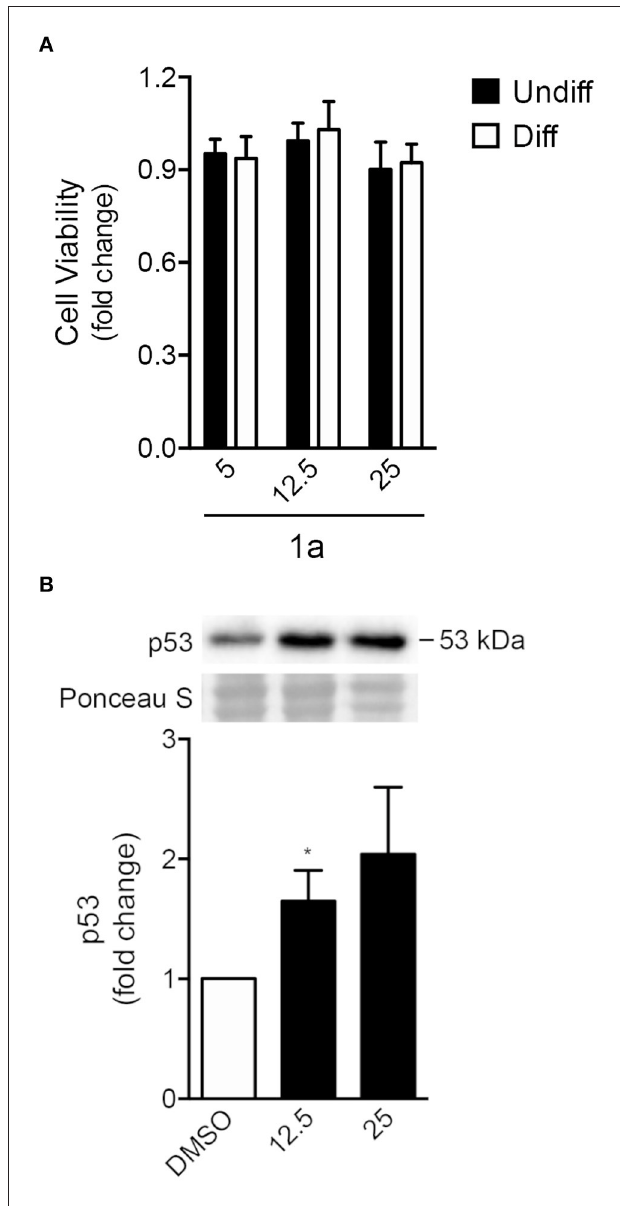
FIGURE 3 | Spiropyrazoline oxindole 1a does not induce significant toxicity but stabilizes p53 protein in NSCs. Mouse NSCs were treated with 5, 12.5, or 25 µ M of compound 1a or DMSO (control) for 24h and collected for viability and Western blot assays as described in Experimental . (A) Cell viability as analyzed by MTS metabolism in self-renewing or differentiating NSCs after 1a treatment (B) Representative immunoblots (top) and corresponding densitometry analysis (bottom) showing increased p53 protein levels in differentiating NSCs after 1a treatment. Ponceau staining was used as loading control. Data represent mean ± SEM fold-change to control of at least three independent experiments. * p < 0.05 from respective control by Student’s t